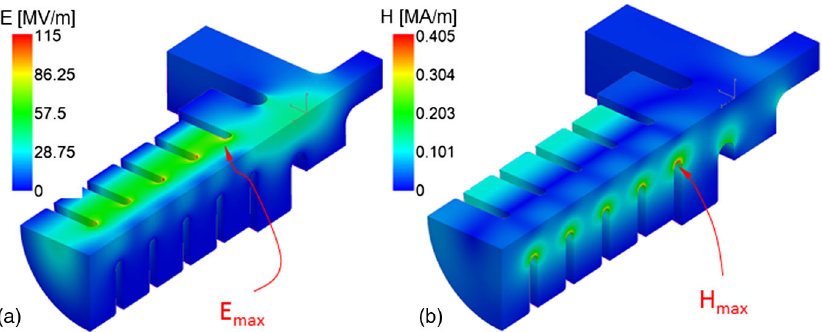
FIG. 4. Waveguide coupler for the rf deflector. Fields are normalized to 20 MW of transmitted power: (a) surface electric fields with maximum value of 100 MV = m; (b) surface magnetic fields with maximum value of 400 kA = m which corresponds to 23 °C peak pulse heating for 110 ns pulse